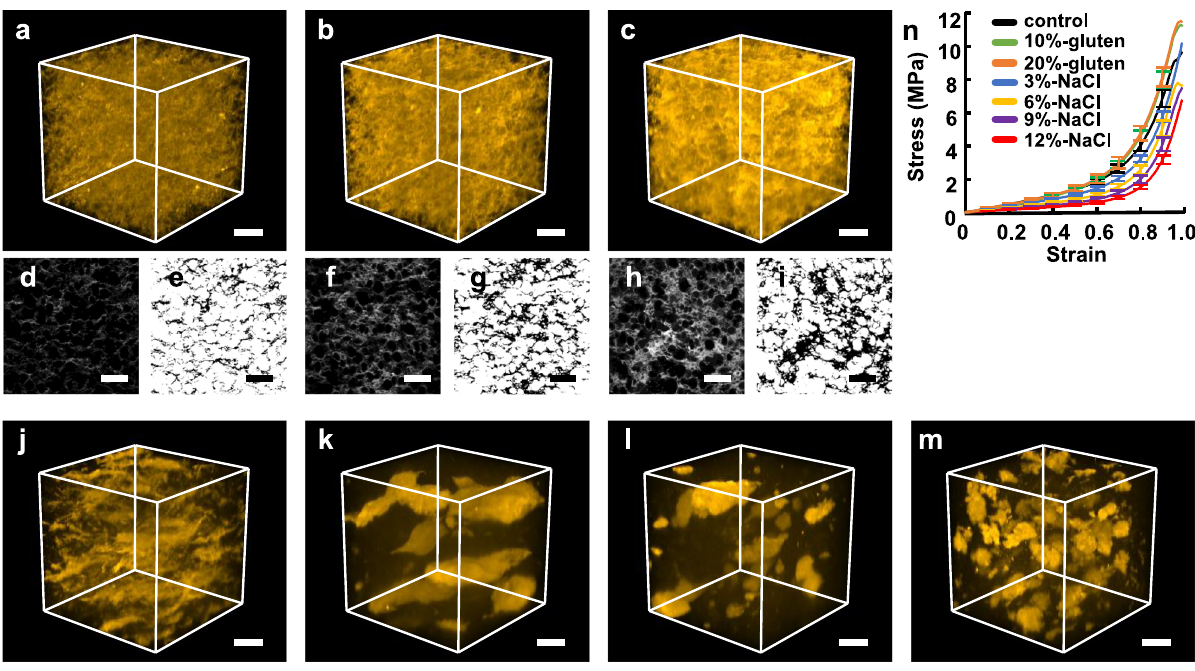
Fig. 5 3D structure of gluten and stress-strain curves for various noodles. a – c , j – m Skeletal structures of gluten labelled with Thiolite TM Green were imaged with 2PEM. The 3D structure of gluten in control noodle ( a ), 10%-gluten noodle ( b ), 20%-gluten ( c ), 3%-NaCl ( j ), 6%-NaCl ( k ), 9%-NaCl ( l ) and 12%-NaCl ( m ). d , f , h Optical sections images in ( a – c ) and binarised images obtained by the Otsu method ( e , g , i ). The percentage of gluten calculated by Otsu method for control noodle, 10%-gluten noodle and 20%-gluten noodle was 13.27 ± 1.01, 21.69 ± 1.02 and 29.60 ± 0.68, respectively (the values show mean ± SD for N = 3 independently prepared noodle samples). Scale bars indicate 100 µ m ( a – m ). Note that when rendering with FluoRender, alpha blending (500) was applied ( a – c , j – m ). The stress-strain curves are shown in ( n ) for control (black), 10%-gluten (green), 20%-gluten (orange), 3%-NaCl (blue), 6%-NaCl (yellow), 9%-NaCl (purple) and 12%-NaCl (red). The strain was normalised by the thickness of each sample, and the stress value for every 0.1 strain from 0.1 to 0.9 was calculated by the interpolation complement method. Data are presented as mean values± SD ( N = 20 different samples taken from the same noodle preparation) ( n ). Source data underlying ( n ) are provided as a Source Data fi le.